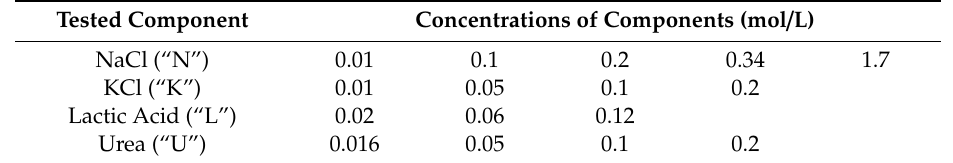
Table 1. Single component solutions under test (synthesized by dissolving in 1 L of distilled water).